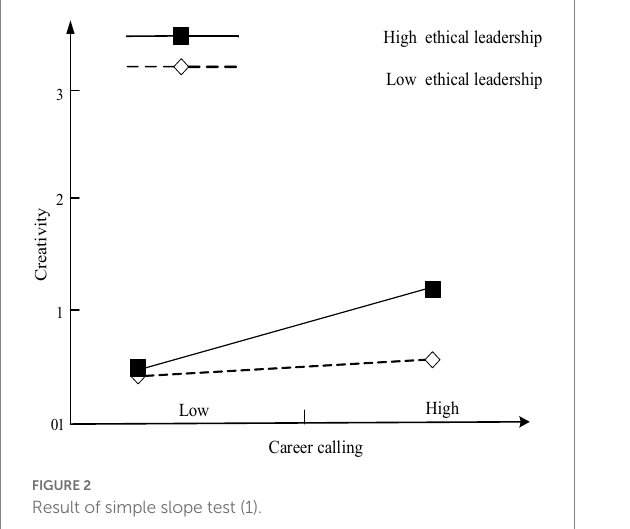
FIGURE 2 Result of simple slope test (1).